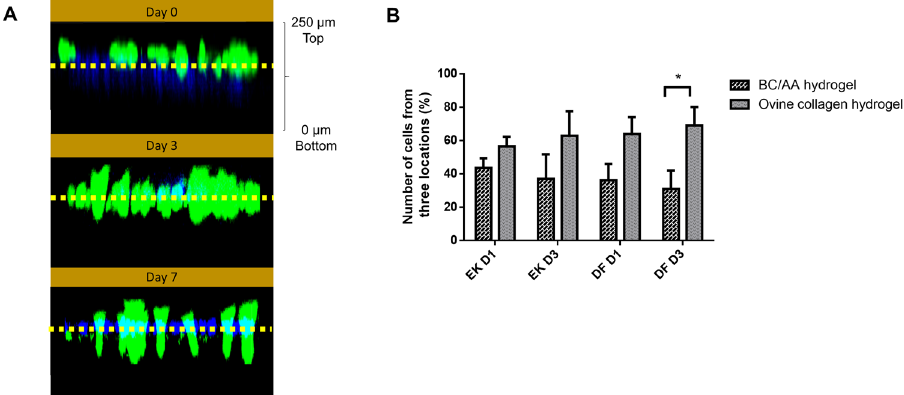
Figure 3. ( A ) 3D confocal imaging of cell migration ( B ) Number of epidermal keratinocytes (EK) and dermal fibroblasts (DF) on BC/AA hydrogel and ovine collagen hydrogel on day 1 (D1) and day 3 (D3) in the cell transfer study. The asterisk ( * ) represents a significant difference (p < 0.05) for DF D3 between BC/AA hydrogel and ovine collagen